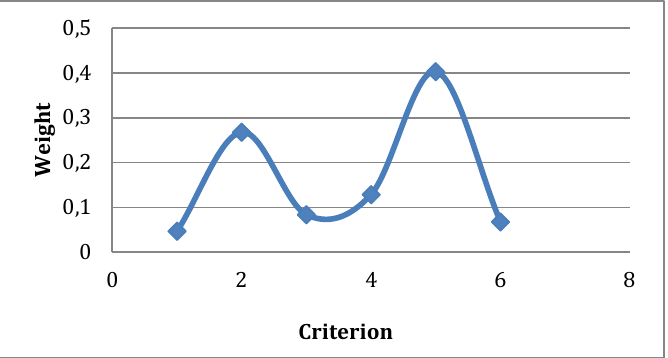
Figure 9: Remanufacturing sustainability assessment criteria